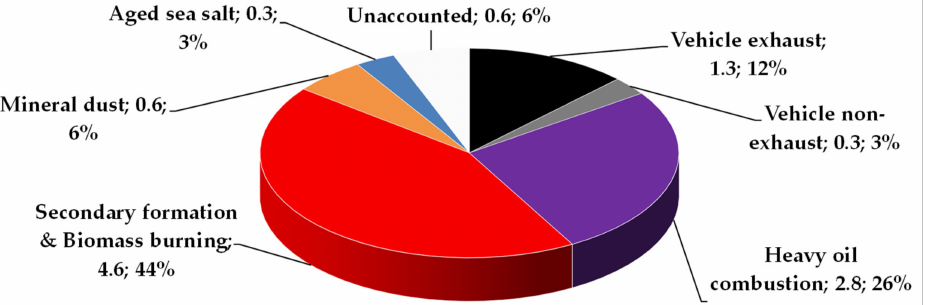
Figure 4. Average contribution (in µ g/m 3 and as % of total PM 2.5 concentration) of the different sources obtained by PMF to the PM 2.5 concentration levels measured during August 2016–July